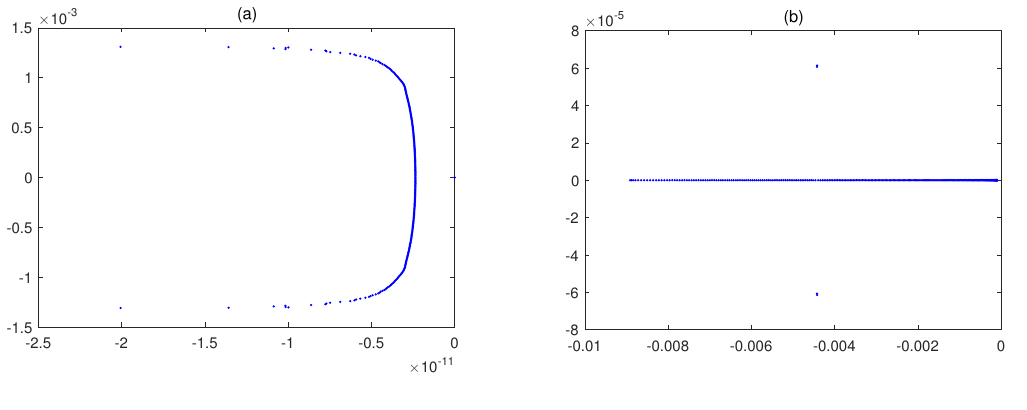
Figure 8. The eigenvalues of A ( a ) and B ( b ) for N = 600, n i = 235 and c = 1.12 in Example